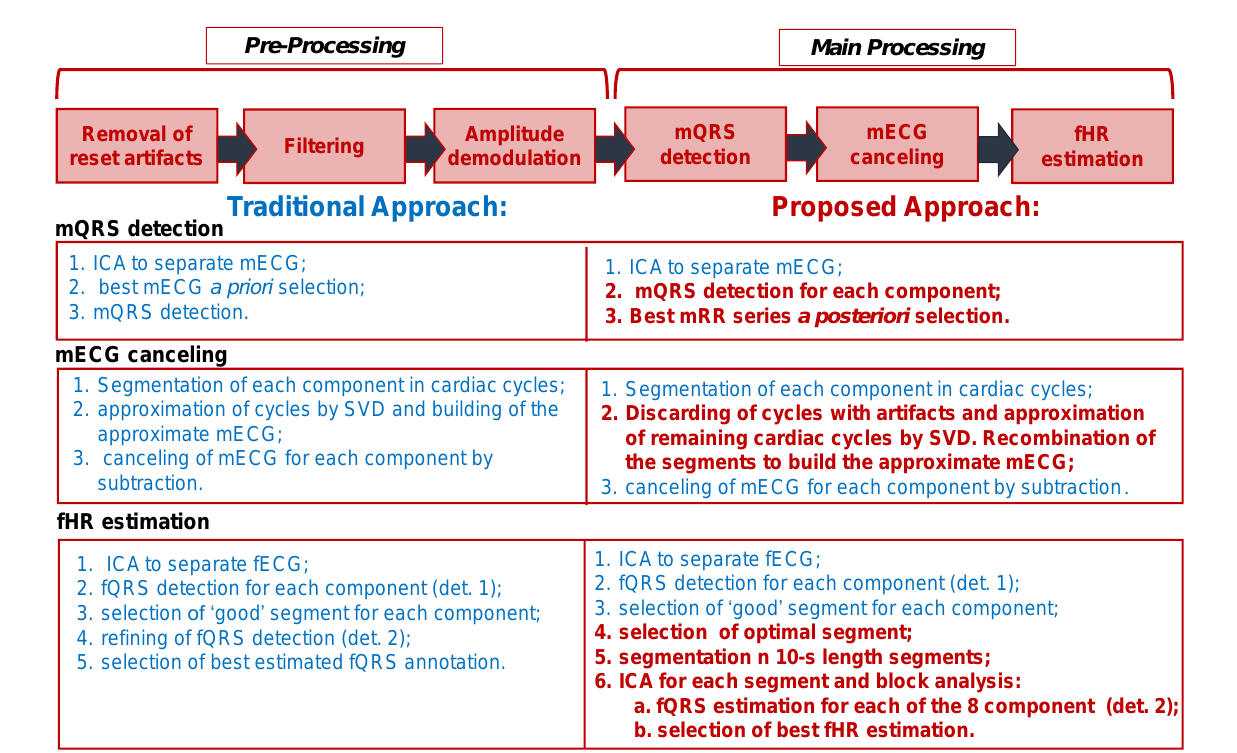
Figure 2. Comparison between the proposed approach and VA. Hybrid (hardware and software) pre-processing consists of the removal of triboelectricity artifacts, filtering, and amplitude demodulation and was introduced in the proposed approach to managing the artifacts typical of signals acquired with dry electrodes. Main-processing consists of three steps, which are the same as in VA, improved to guarantee robustness against artifacts. In the three lower blocks, the details of each step are reported both for VA and the proposed approach. In red, the modifications introduced are reported, and in blue, the stages that remain unchanged are